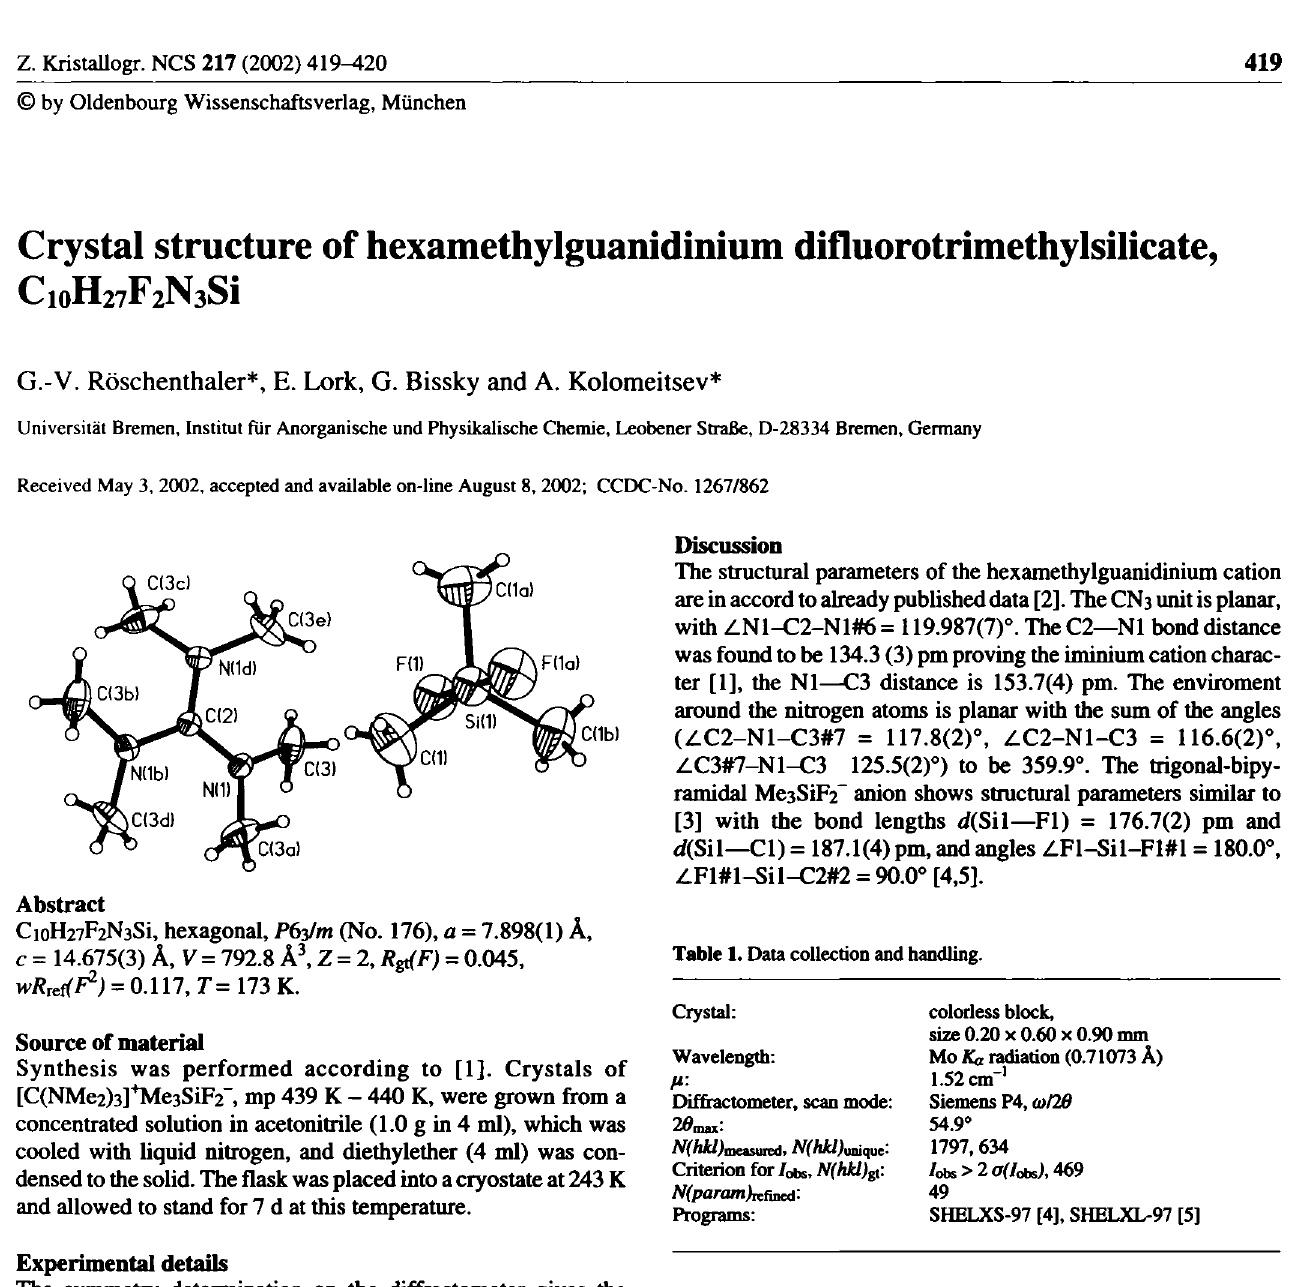
Table 2. Atomic coordinates and displacement parameters (in Â 2 ).